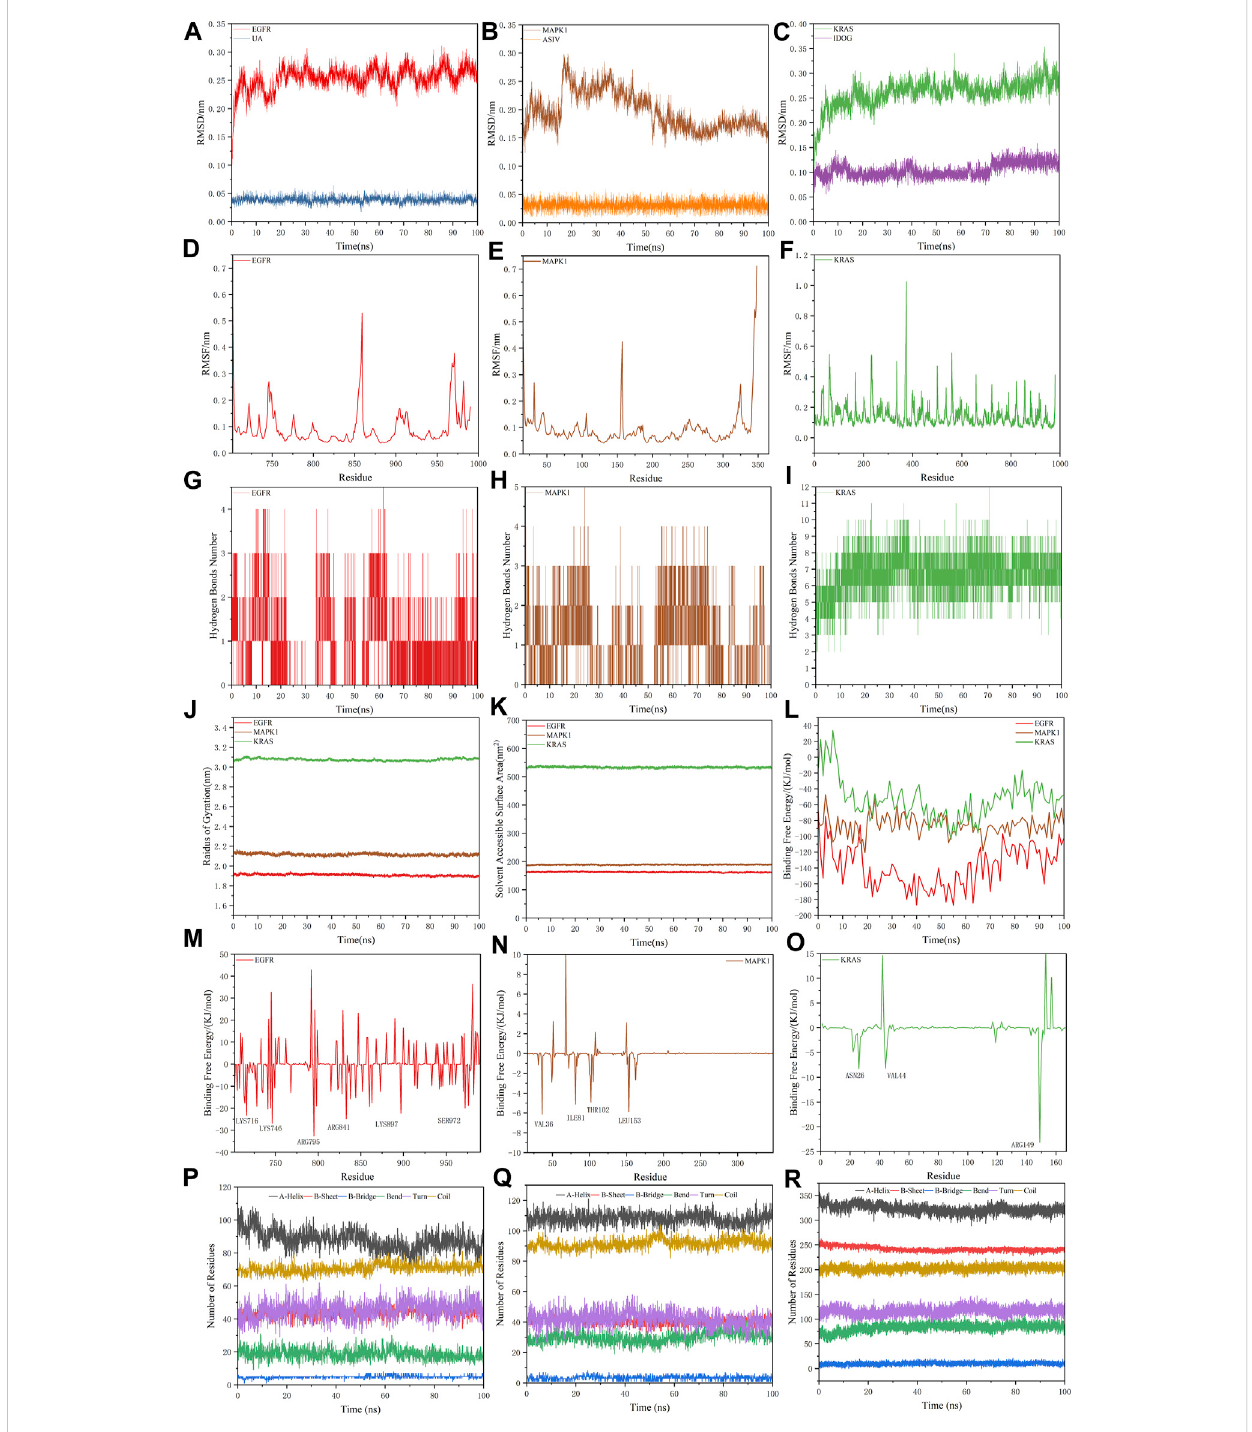
FIGURE 8 Molecular dynamics simulations. (A – C) The RMSD plot of EGFR-UA, MAPK1-ASIV and KRAS-IDOG. (D – F) The RMSF plot of EGFR-UA, MAPK1-ASIV and KRAS-IDOG. (G – I) The hydrogen bond numbers of EGFR-UA, MAPK1-ASIV and KRAS-IDOG. (J,K) Rg and SASA plots of EGFR-UA, MAPK1-ASIV and KRAS-IDOG. (L) BindingFreeEnergyplotsofEGFR-UA,MAPK1-ASIVandKRAS-IDOG. (M – O) Bindingenergycontribution plotsofaminoacidresiduesof EGFR-UA, MAPK1-ASIV and KRAS-IDOG. (P – R) The secondary structure analysis plot of EGFR-UA, MAPK1-ASIV and